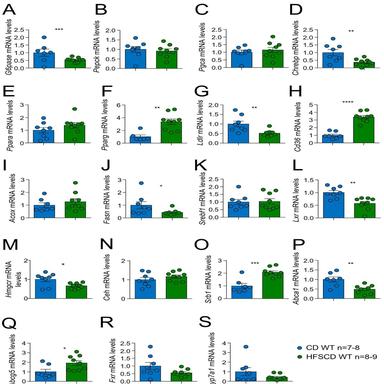
WT mice fed with the HFSCD for 16 weeks, presents deranged hepatic metabolic gene expression. mRNA levels of (A) G6pase, (B) Pepck, (C) Pgca, (D) Chrebp, (E) Ppara, (F) Pparg, (G) Ldlr, (H) Cd36, (I) Acox, (J) Fasn, (K) Srebf1, (L) Lxr, (M) Hmgcr, (N) Ceh, (O) Srb1, (P) Abca1, (Q) Abcg5, (R) Fxr, and (S) Cyp7a1. mRNA levels were normalized to endogenous Cyclophilin expression and relativized to WT mouse levels. Data was represented as individual data points and with the mean±sem. Statistical analysis was pe